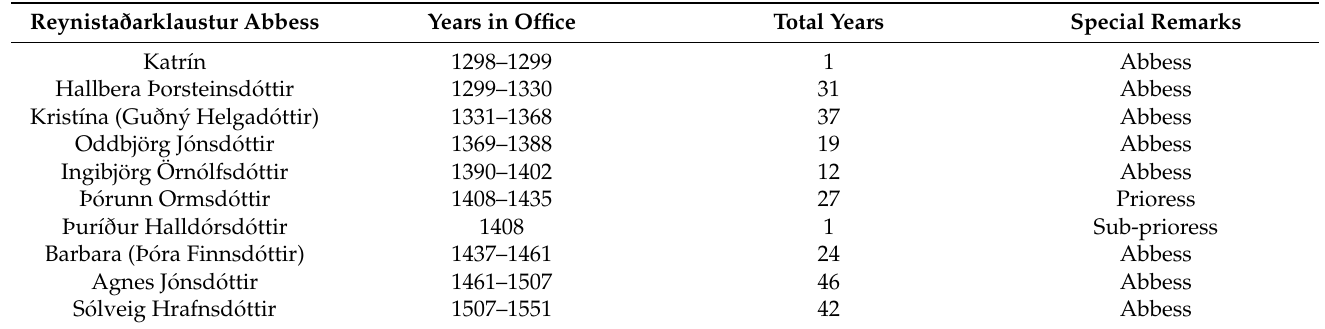
Table 2. The abbesses and prioresses of